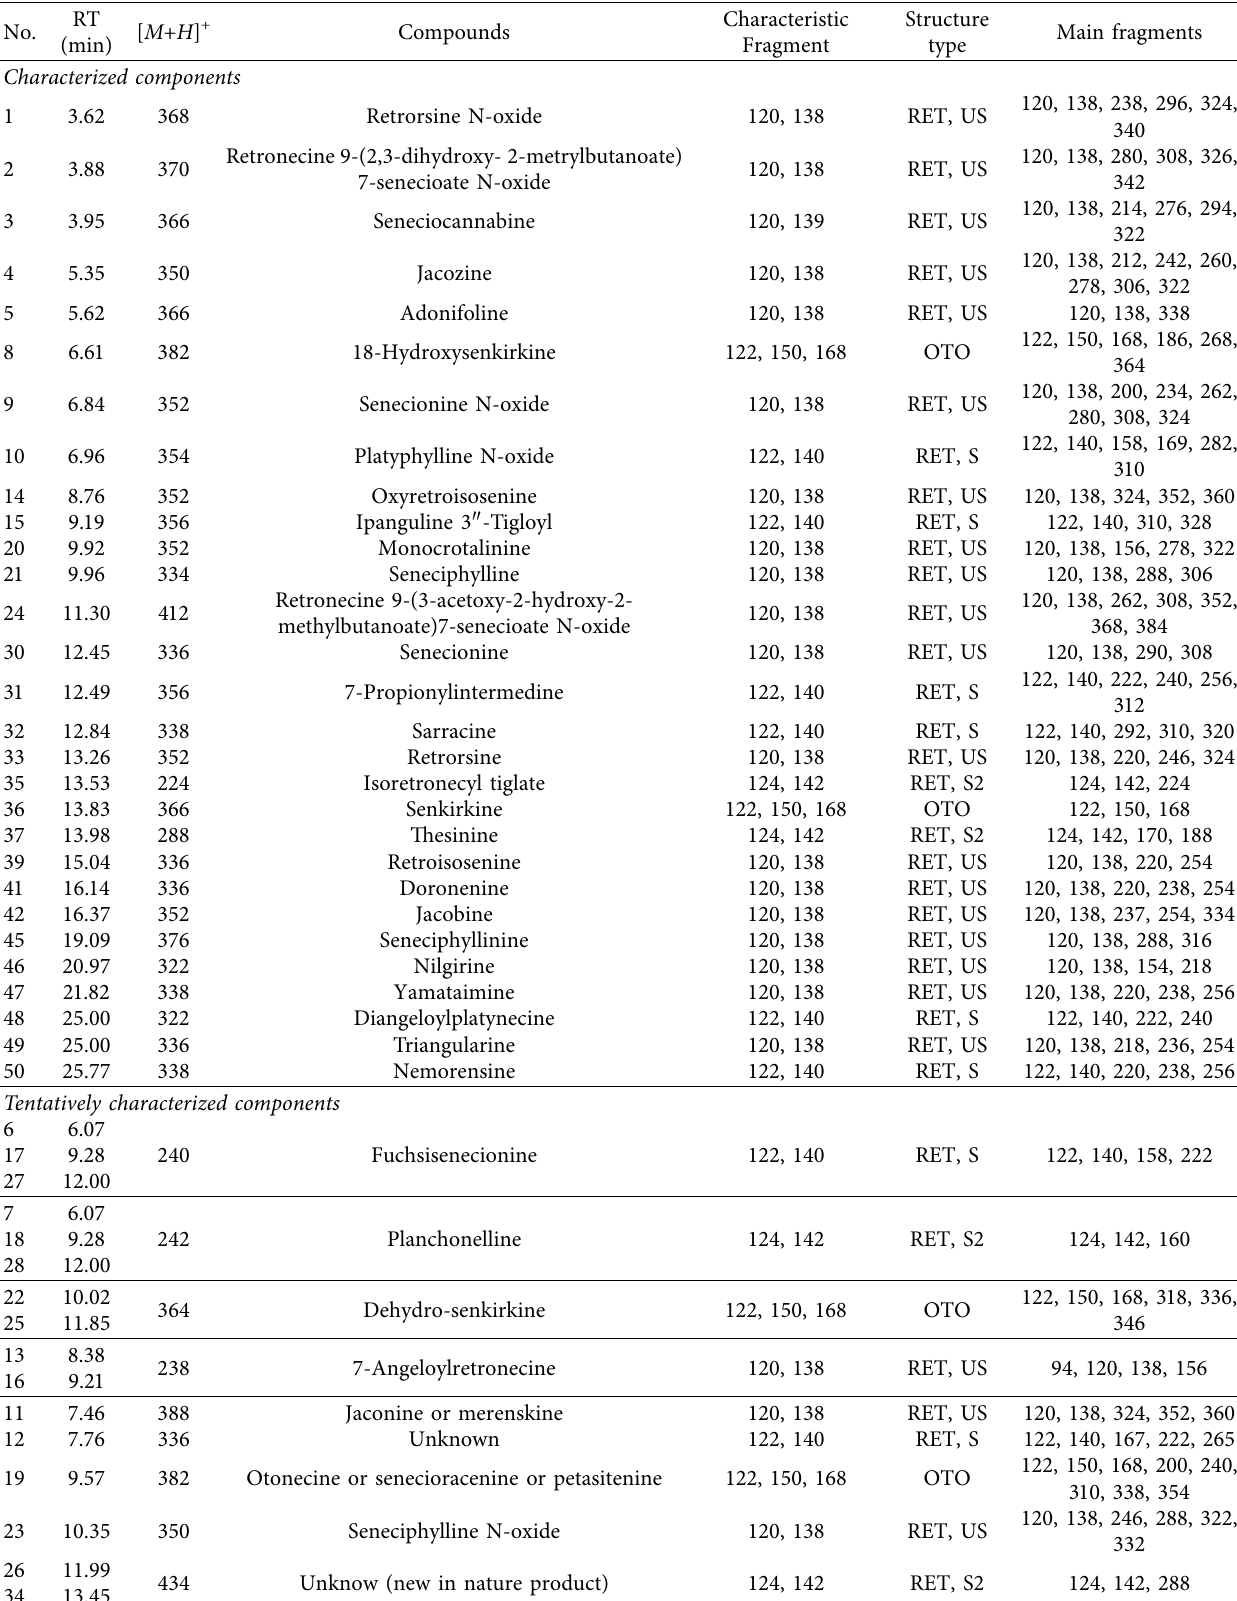
Table 1: Characterization of major compounds from five Senecio